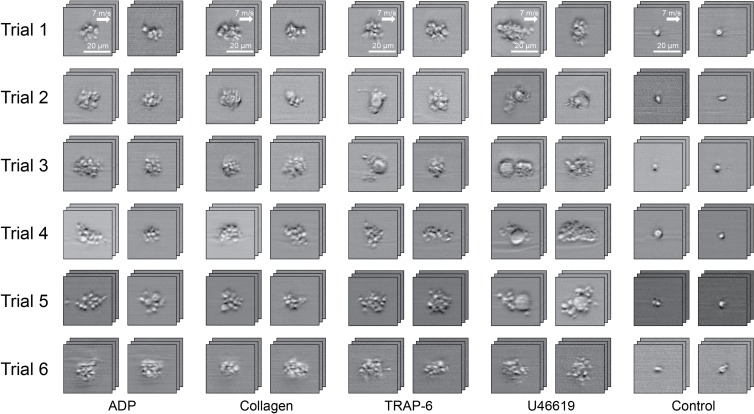
Extend Image Library from Six Experimental Trials.